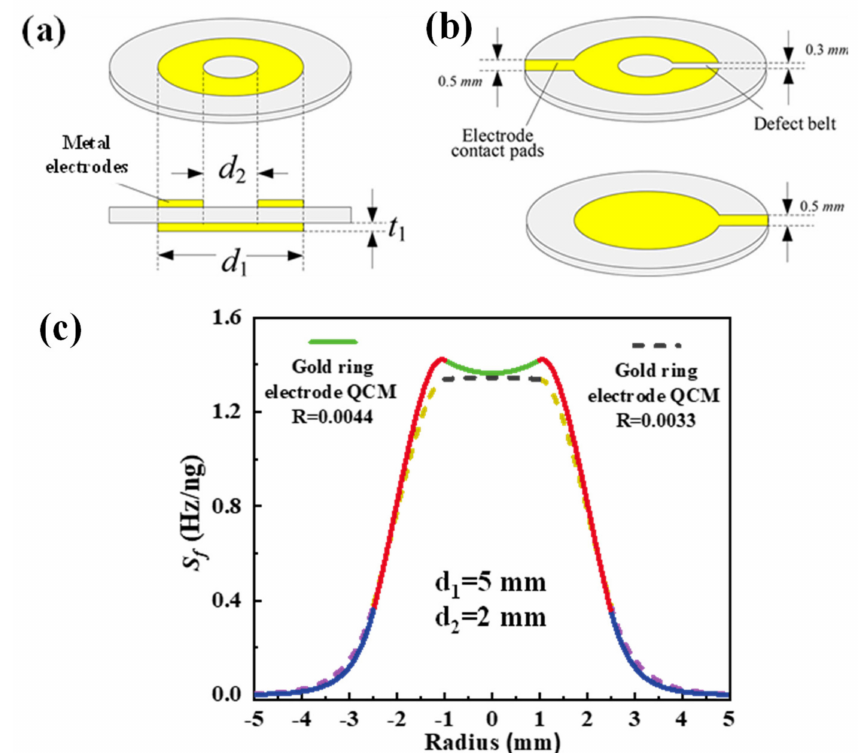
Figure 6. ( a ) The angled view (upper) and profile map (lower) of the ideal ring electrode QCM, where t 1 is the thickness of the electrode and d 1 and d 2 are the outer and inner diameters of electrode, respectively. ( b ) The ring-electrode on the topside (upper) and circle-electrode on the backside (lower) of actual ring electrode QCM. ( c ) Mass sensitivity distribution of AT-cut 10 MHz ring electrode QCM having inner and outer diameters of 2 and 5 mm, respectively